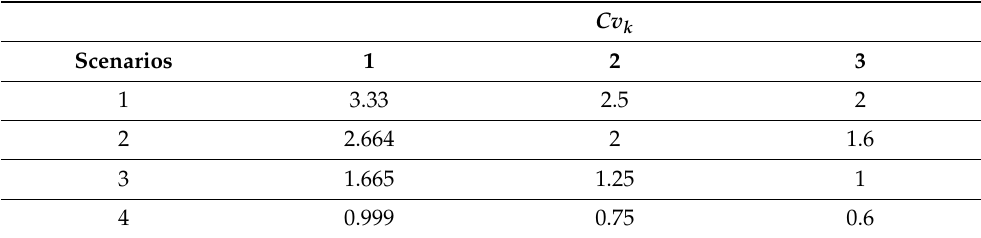
Table 3. Different scenarios with different variable costs of service overtime in each consultation room.